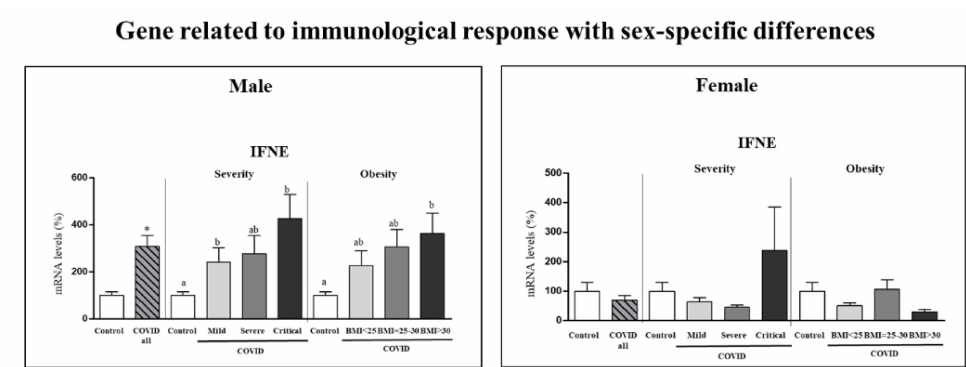
Figure 4. Expression levels in PBCs of the indicated gene related to immunological response in controls and COVID-19 patients (male and female) and separated according to COVID-19 severity and obesity in each sex. mRNA levels were measured by real-time qPCR and expressed as a percentage of the value of the respective control sex (male or female). Data are expressed as the mean ± SEM. Statistics: differences between stratified groups were analyzed by one-way ANOVA followed by least significant difference (LSD) post-hoc test, a (cid:54) = b ( p < 0.05). Student’s t test was used for single comparisons: *, COVID all vs